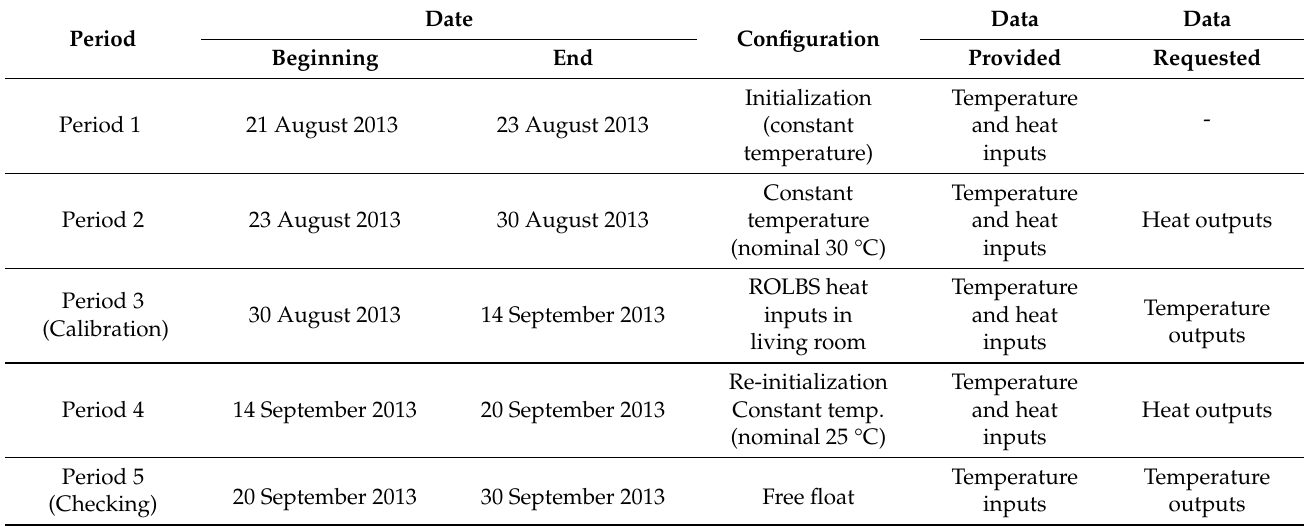
Table 1. Period features used in the research study of Annex 58.